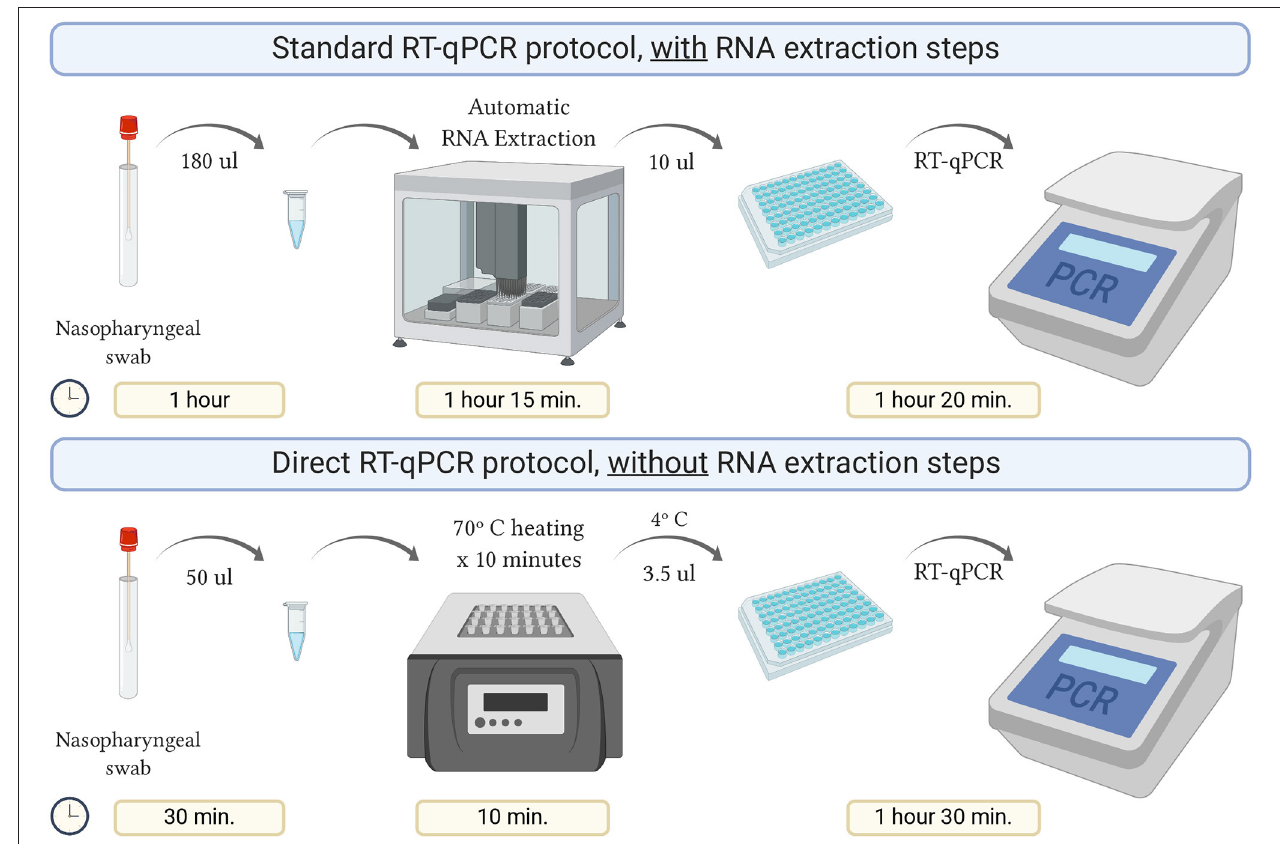
FIGURE 1 | Schematic representation of the direct RT-qPCR protocol without RNA extraction steps, compared to the standard protocol. Created with BioRender.com.